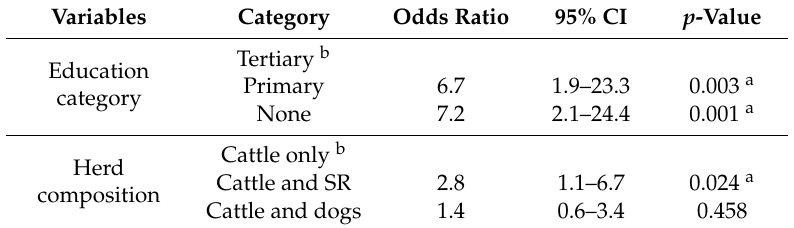
Table 3. Results of multivariable logistic regression between potential herd risk factors and the serological status of brucellosis in cattle farmed at the wildlife-livestock-human interface in